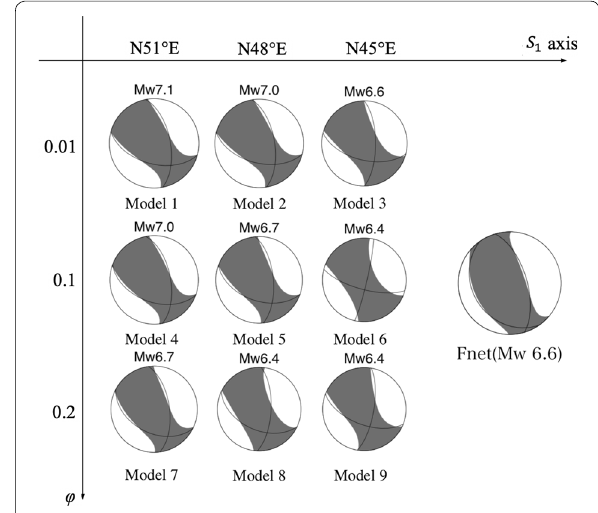
Fig. 13 CMT solutions for different stress